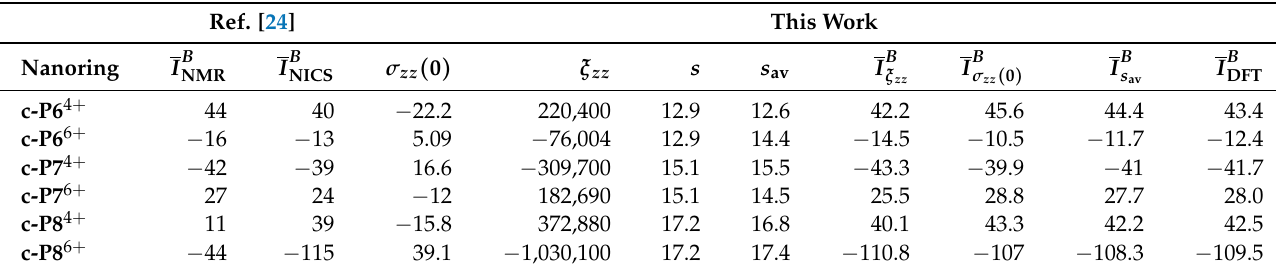
Table 1. Estimation of the signed current strength of the nanorings from the magnetic properties computed at the LC- ω hPBE ( ω = 0.1)/6-31G* level. Nuclear magnetic shielding and magnetizability components σ zz ( 0 ) and ξ zz in ppm and 10 − 30 J T − 2 ,